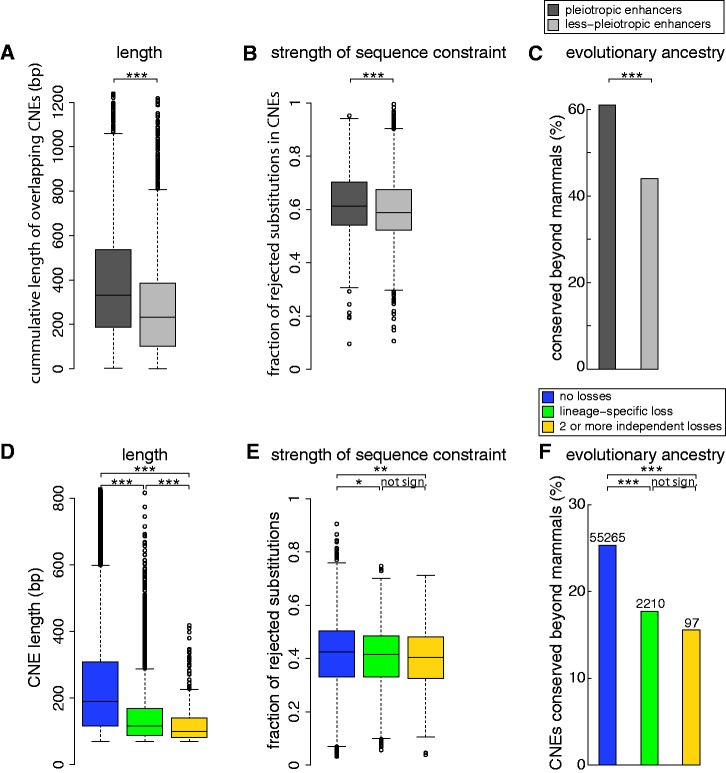
Differences in features indicative of pleiotropy between CNEs with and without losses. (A–C) We compared less pleiotropic enhancers (regions bound by p300 in only one of developing forebrain, midbrain or limb tissue (39)) to pleiotropic enhancers (bound by p300 in two or three of these tissues). (A) Less pleiotropic enhancers have fewer bases overlapping CNEs. (B) Less pleiotropic enhancers overlap CNEs that have a lower level of constraint, as measured by the fraction of substitutions that is rejected by purifying selection (calculated with GERP (27)). They are also less often extremely constrained (for 19.8% versus 25.7% more than 70% of the substitutions are rejected by selection). (C) Less pleiotropic enhancers align less frequently to non-mammalian vertebrates (chicken, zebra finch, lizard, frog or fish), showing that they are evolutionarily younger. (D–F) We compared CNEs with no detected losses to CNEs with lineage-specific and independent losses. The CNEs with losses show signatures indicative of less pleiotropy. (D) CNE length decreases with the number of loss events. (E) CNEs with loss events are depleted in extremely constrained elements. (F) CNEs with loss events are evolutionarily younger. Box plots visualize the distribution in (A), (B), (D) and (E). Bar charts are shown in (C) and (F). For visualization clarity the Y-axis is cut at a size of 1200 bp in (A) and 800 bp in (D). Wilcoxon rank-sum test was used in (A), (B), (D), (E), chi-square test in (C) and (F). ***P-value < 0.0001; **P-value < 0.01; *P-value < 0.05.